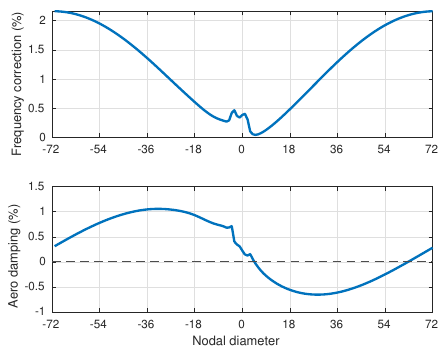
Figure 2. Frequency correction ( top ) and aerodynamic damping ( bottom